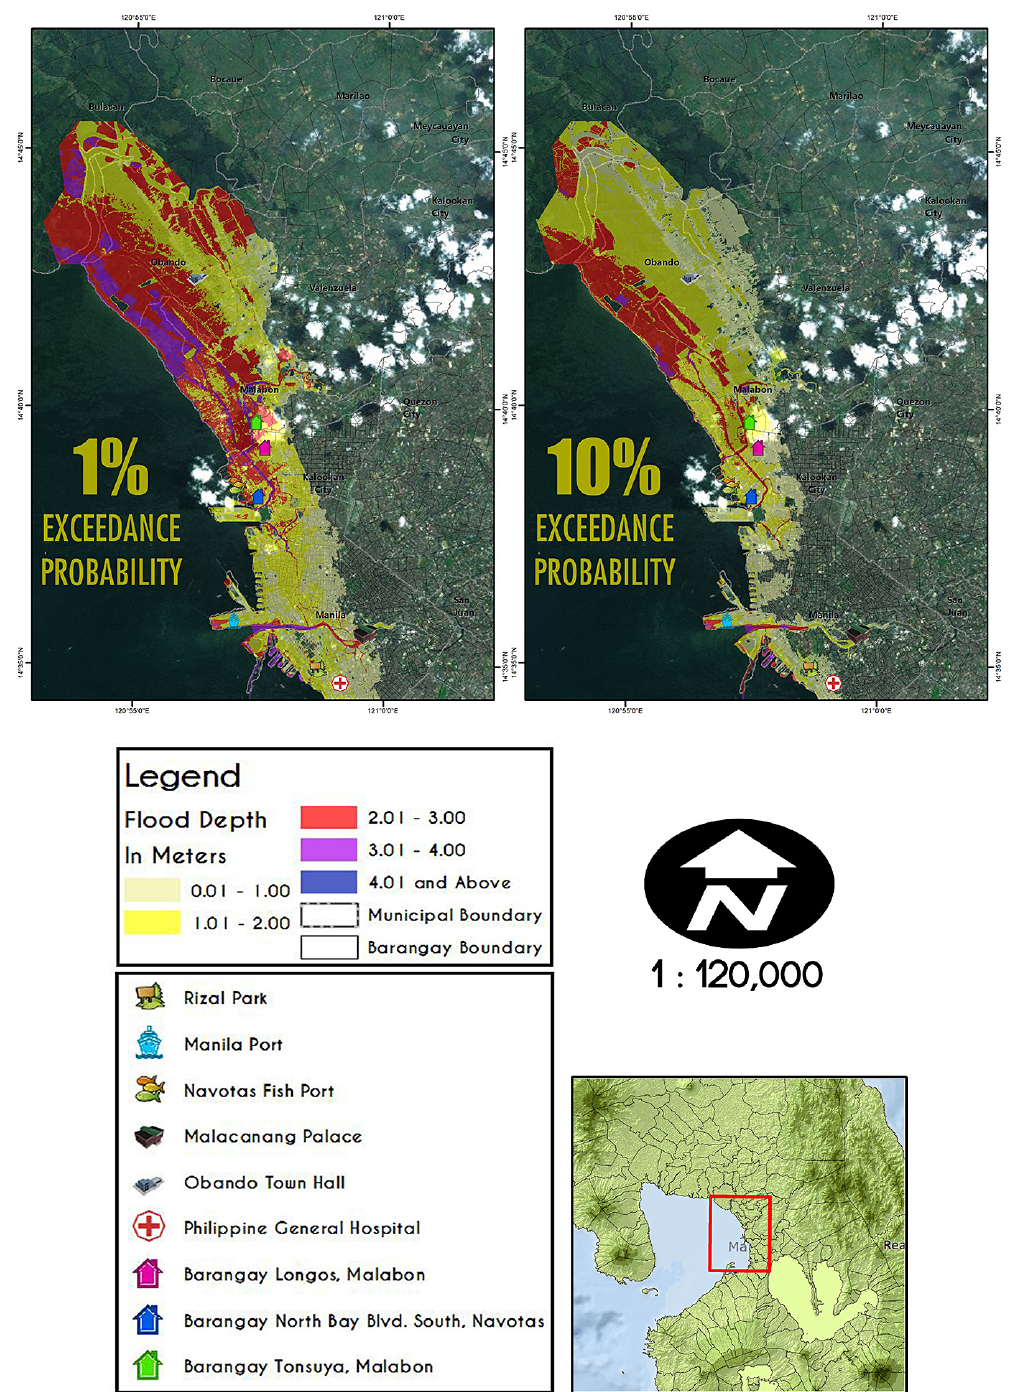
Figure 12. Storm surge inundation maps for PSWS 4 (with